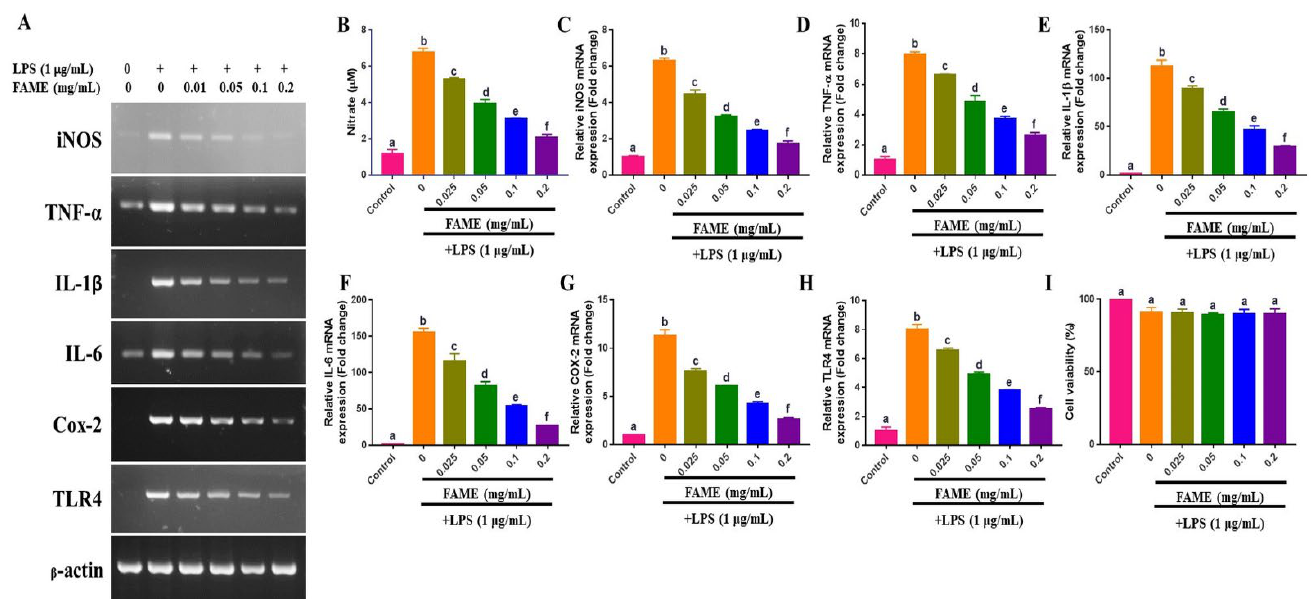
Figure 4. Production of NO and expression of different cytokines in LPS-treated RAW 264.7 cells upon treatment with FAME. Effects of FSE on LPS-induced NO production ( B ). Expression of proinflammatory cytokine mRNA determined by conventional PCR and qRT-PCR: iNOS ( A , C ), TNF- α ( A , D ), IL- 1β ( A , E ), IL-6 ( A, F ), and Cox-2 ( A , G ). Expression of TLR4 mRNA ( A , H ) and cell viability ( I ). The data are presented as the mean ± SEM of three independent experiments. Different letters (a–f) above the bars indicate significant differences ( p < 0.05) between groups.